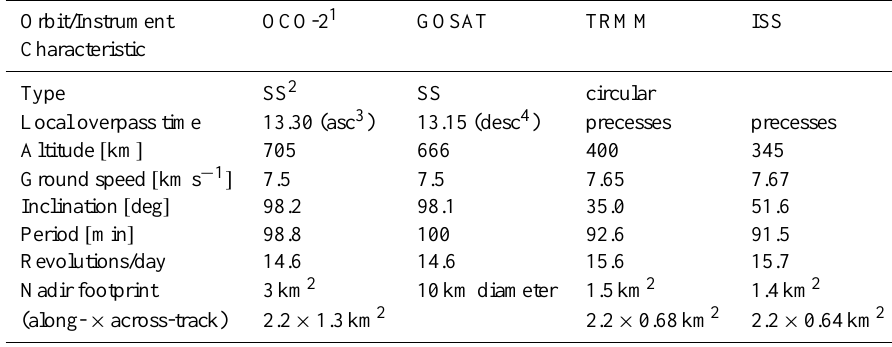
Table 1. Orbital parameters used to determine mission concepts